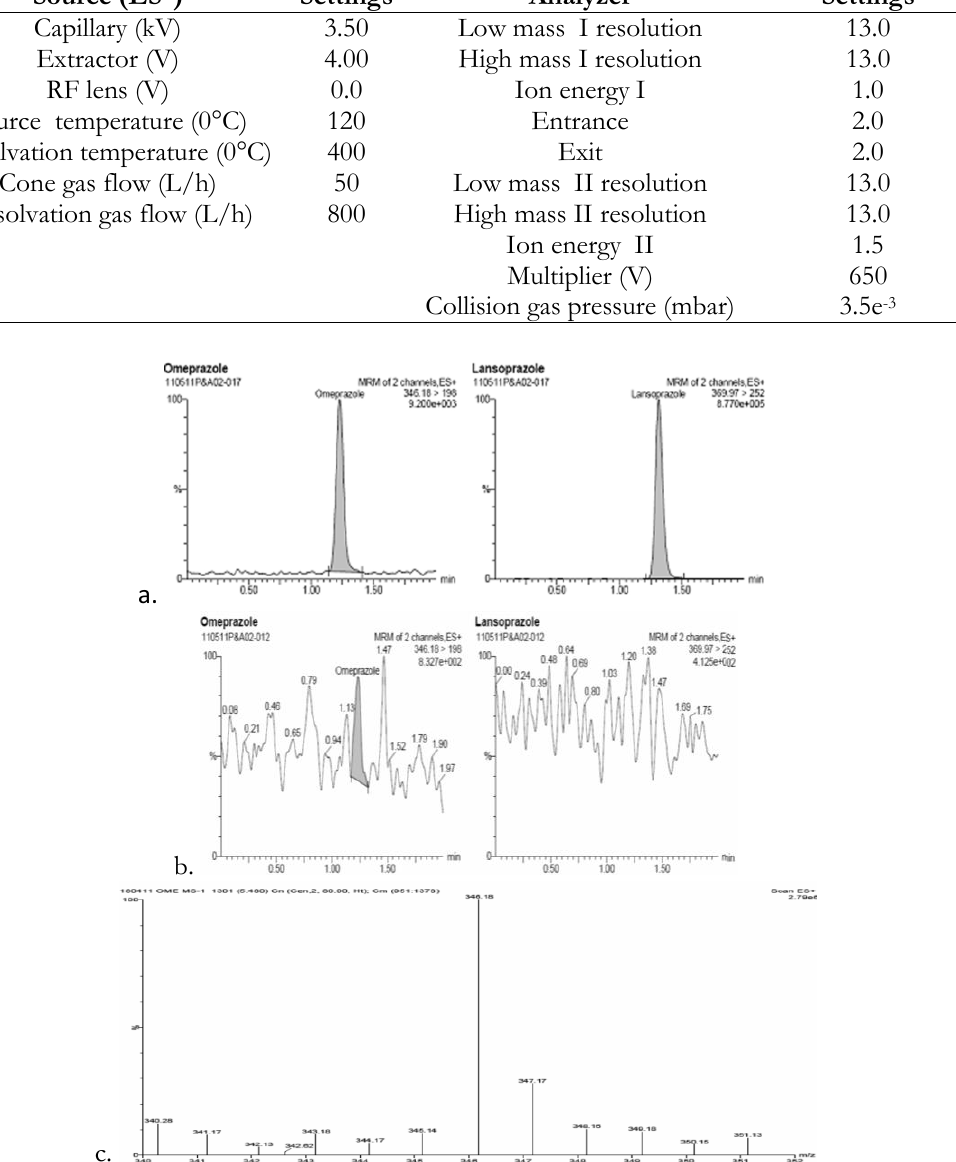
Table I. Settings for MS – MS detection of omeprazole Source (ES + ) Settings Analyzer